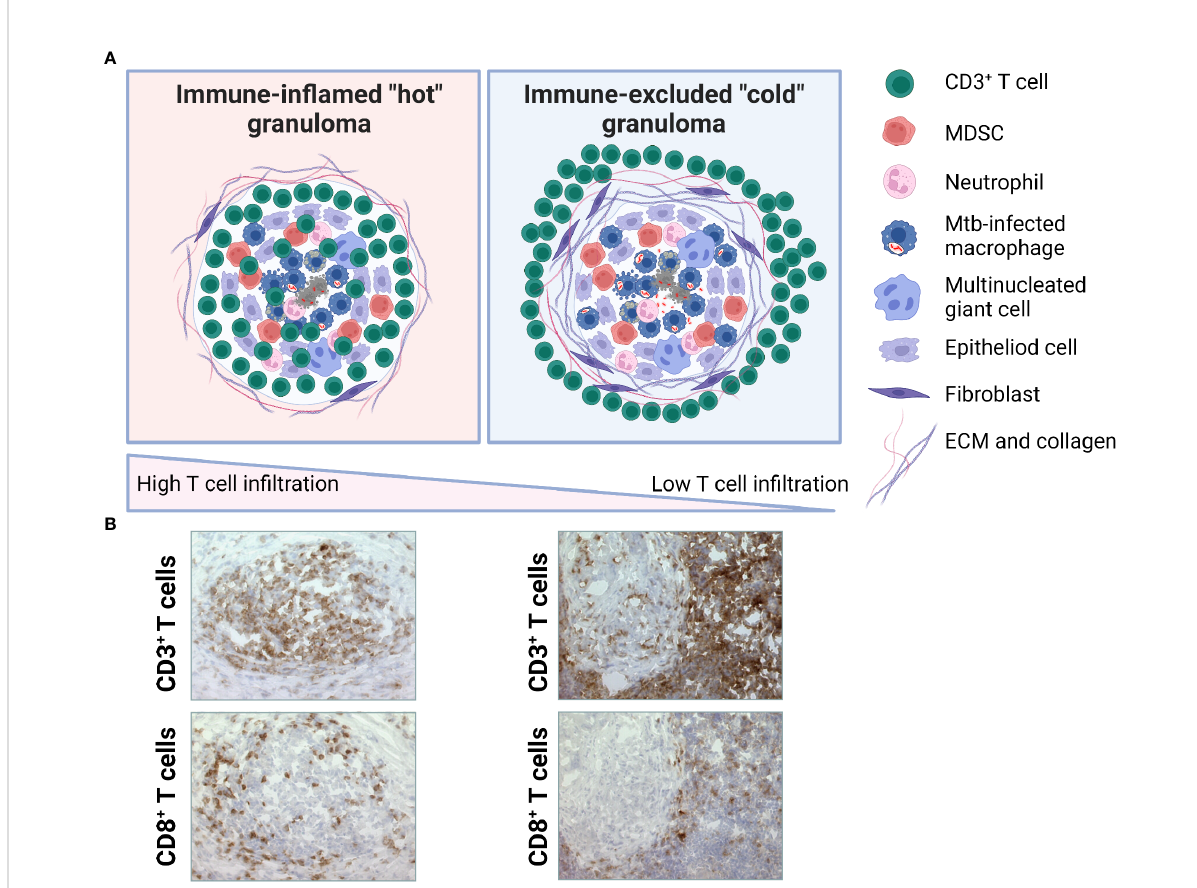
FIGURE 4 Putative TB granuloma phenotypes. (A) Immune-in fl amed or hot TB granuloma (left) is characterized by intermediate-high T cell in fi ltration. These may include both effector T cells and Treg cells at various ratios. Immune-excluded or cold TB granuloma (right) is characterized by low- absent T cell in fi ltration. T cells are mostly localized around the fi brotic capsule of the lesion. Based on the spatial distribution of CD3+ T cells in the GME, a gradient of these immunophenotypes may be observed. (B) Microscopic images illustrating immunhistochemical staining of CD3+ or CD8+ T cells in the GME of selected granulomas from two patients with a local lymph node TB. Representative of immune-in fl amed, hot granulomas (left) and immune-excluded, cold granulomas (right). Magni fi cation is